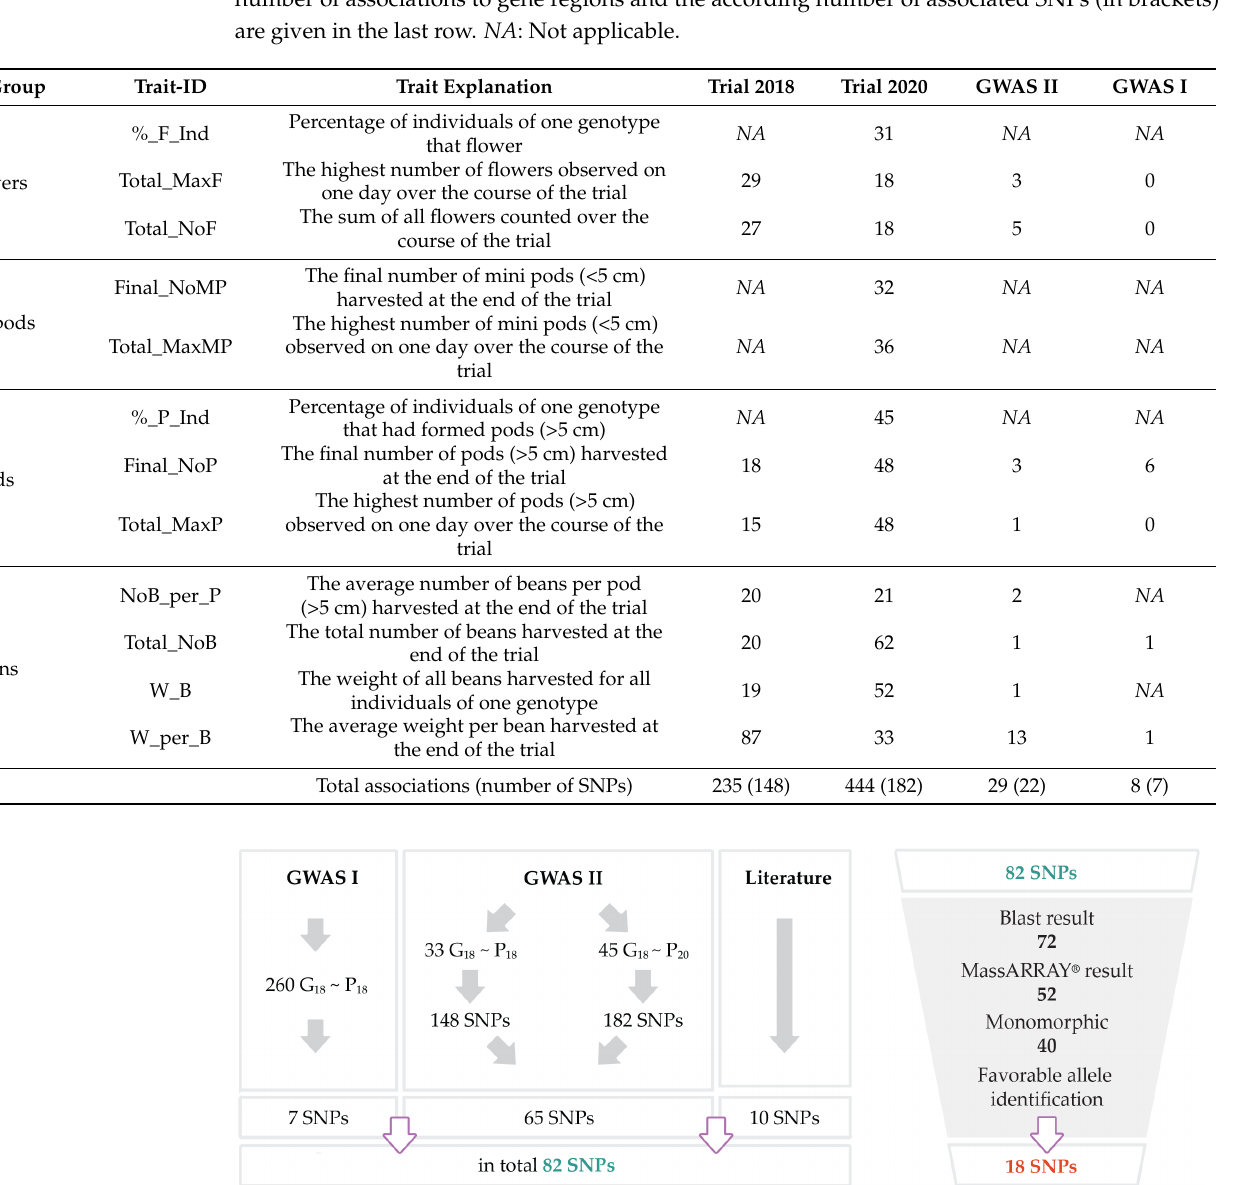
Figure 5. SNPs selection process. Left : The collection of SNPs by GWAS I + II and literature (cf. Table S4). Right : Subsequent filtering steps during MassARRAY ®